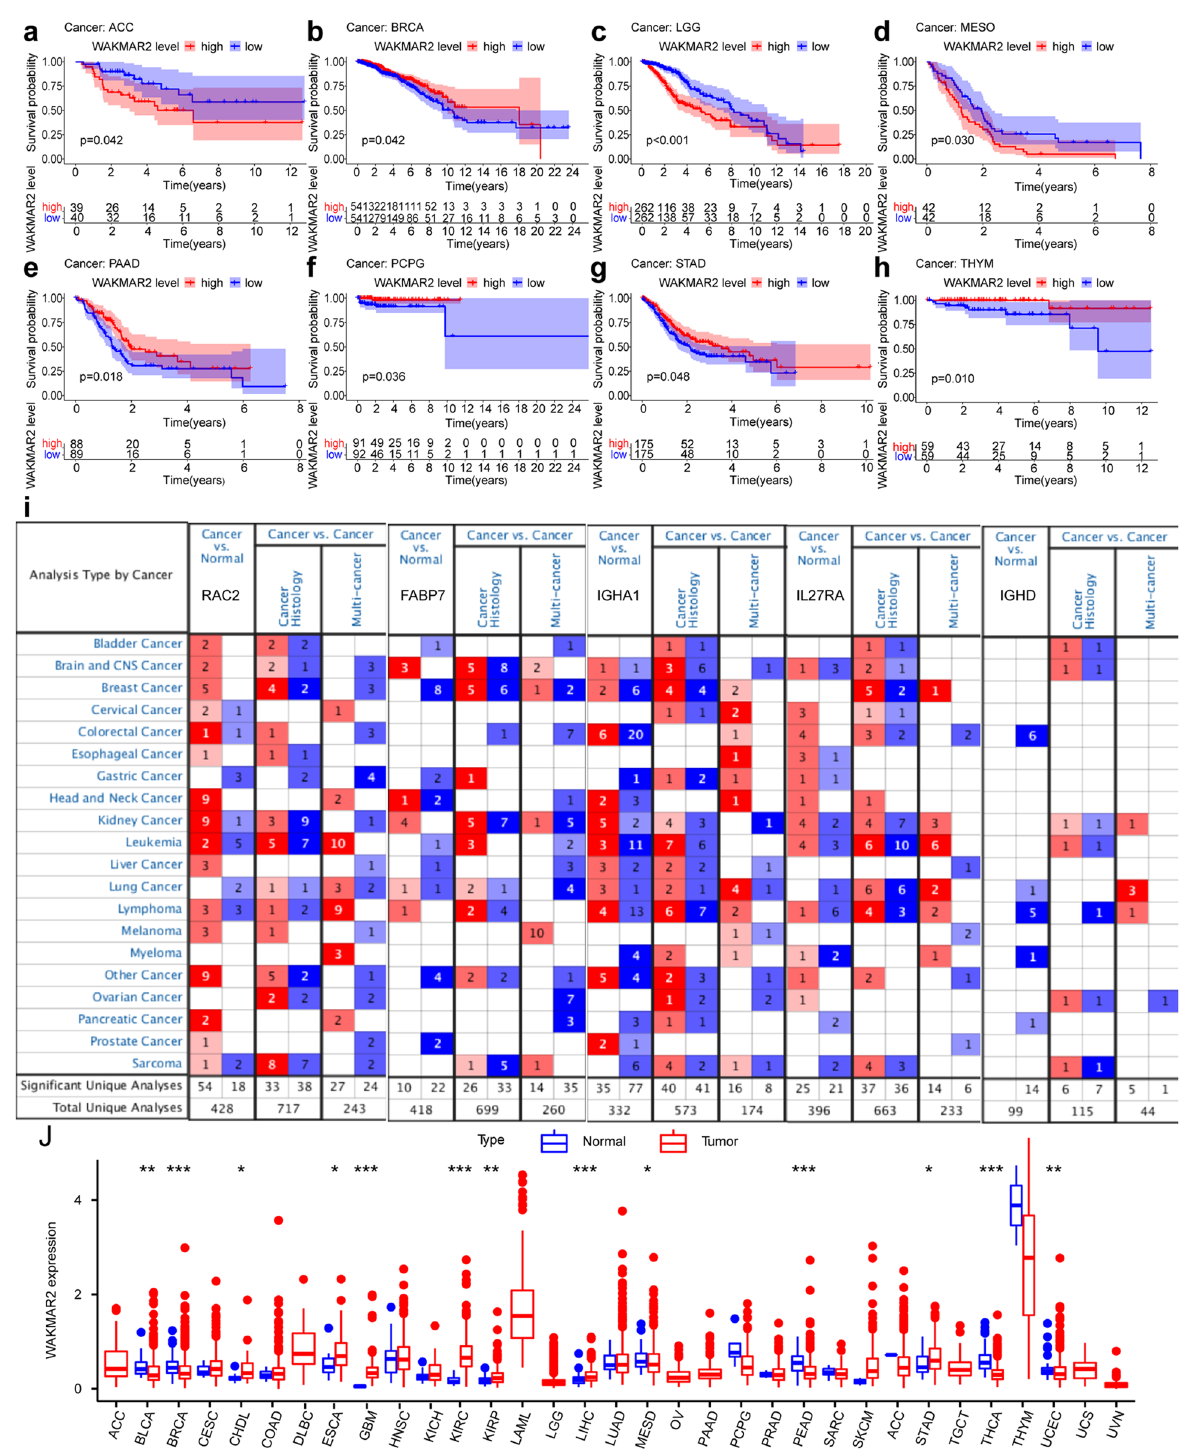
Figure 8. Pan-cancer verification. ( a – h ) Survival analysis of WAKMAR2 in pan-cancer. ( i ) The oncomine database results verified the expression of WAKMAR2 target prognostic genes in pan-cancer. ( j ) Differential expression verification of WAKMAR2 in